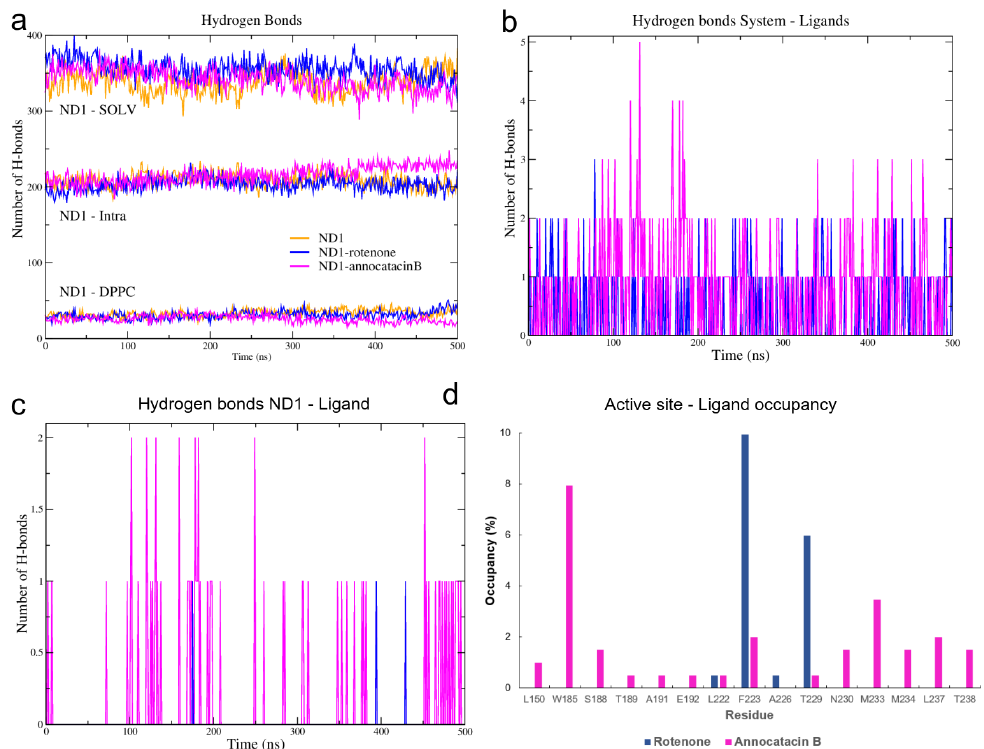
Figure 6. H-bond analysis of the ND1 complexes during 500 ns MD simulations. ( a ) ND1- intramolecular and ND1-intermolecular interactions (solvent and lipid-bilayer). ( b ) H-bond for- mation between the molecular systems and the ligand molecules ( c ) H-bond formation taking into account just the ND1 subunit and the ligand molecules. ( d ) H-bond occupancy of the active site residues interacting with the ligand